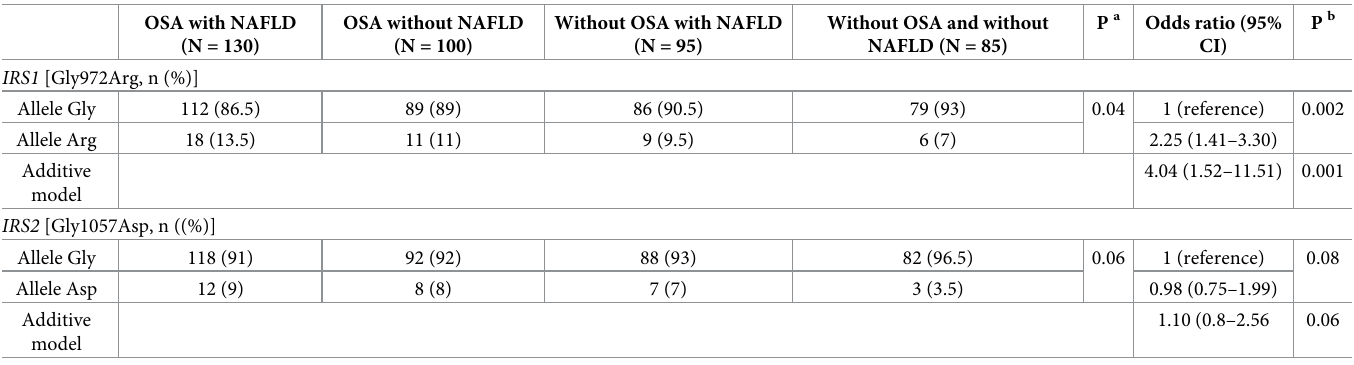
was obtained in OSA and NAFLD (p = 0.05). The deviation from Hardy-Weinberg equilib- rium among OSA and NAFLD patients for IRS1 ( Gly972Arg) (p = 0.001) indicated significant association between this SNP and the presence of OSA and NAFLD. The overall genotypic Table 4. Allele distribution of IRS1 and IRS2 genes polymorphisms between the groups. OSA with NAFLD (N =